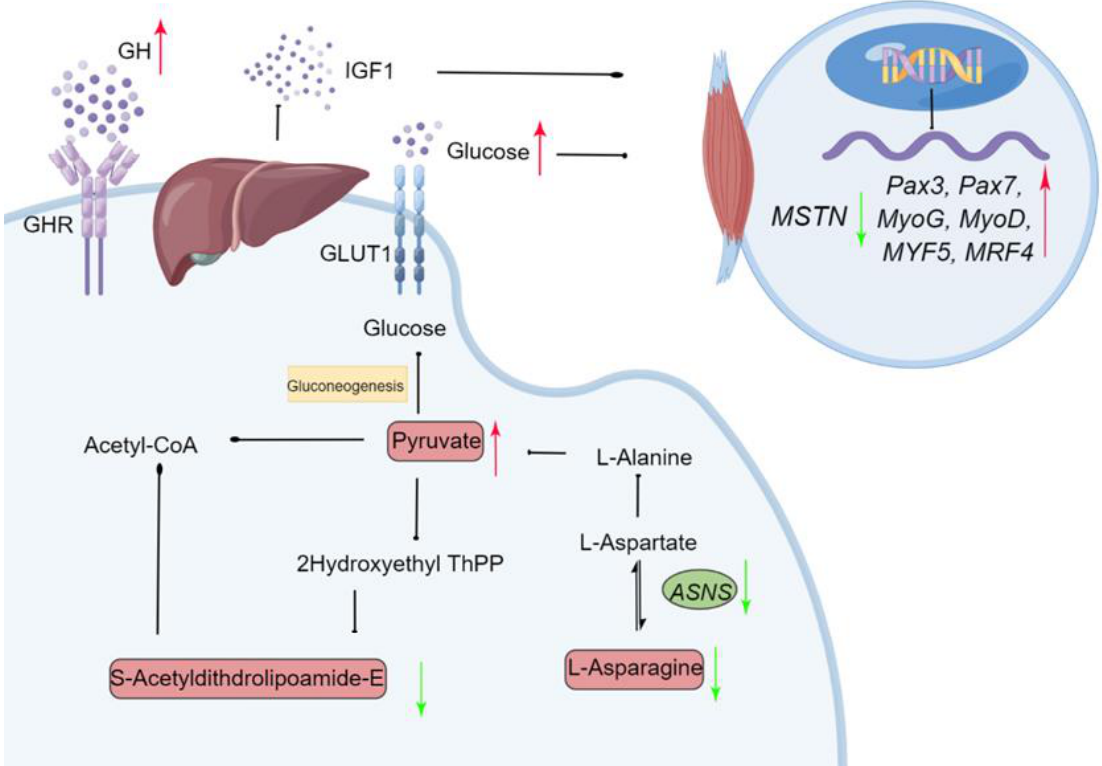
Figure 9. Schematic diagram of the proposed molecular mechanism for monochromatic green light photostimulation during incubation induced improving embryonic development in Yangzhou goose eggs. Green arrow (downregulated) and red arrow (upregulated) in the green light vs. the dark treatments. Gene names were described in italics and metabolites names in normal font. ASNS: Asparagine synthetase; GLUT1: Glucose transporter 1; GHR: Growth factor receptor.